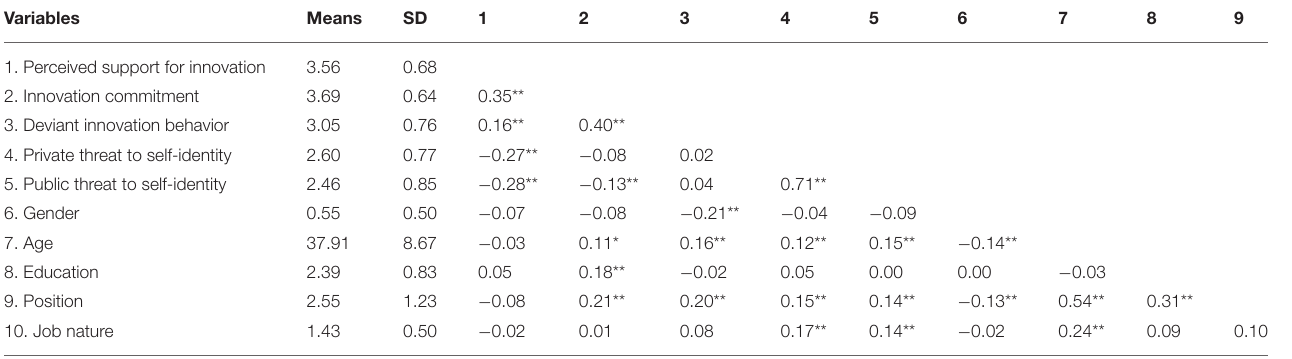
TABLE 1 | Descriptive statistics and correlations ( N = 393). Variables